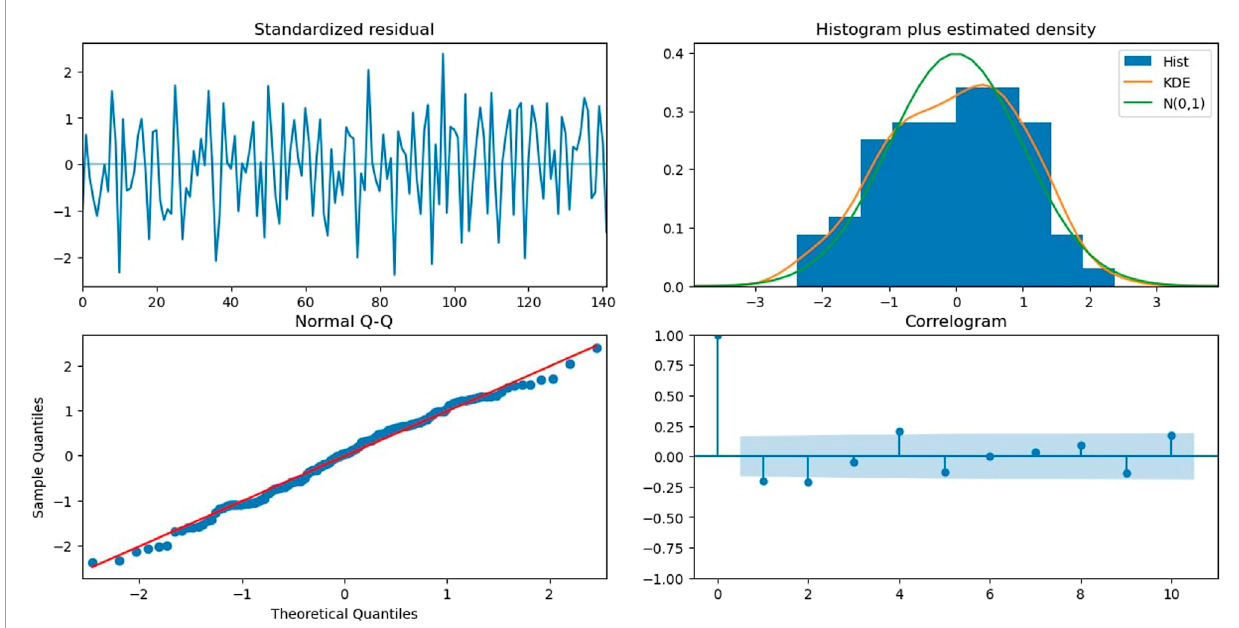
FIGURE 9 Diagnostics for the ARMA (1,1) model.